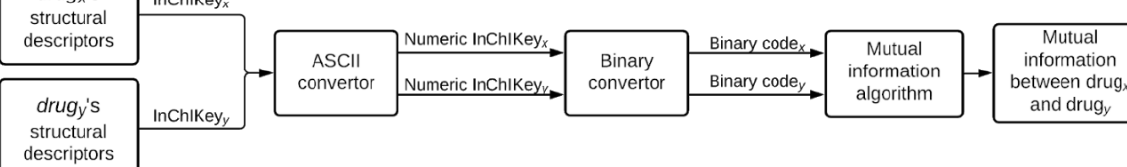
Figure 5. The overview of our method of measuring the structural resemblance between 2 drugs (x and y). For this paper, to confirm the anti-TB properties for some tested compounds, we consider x a test compound and y an approved drug from DrugBank 5.1.8.